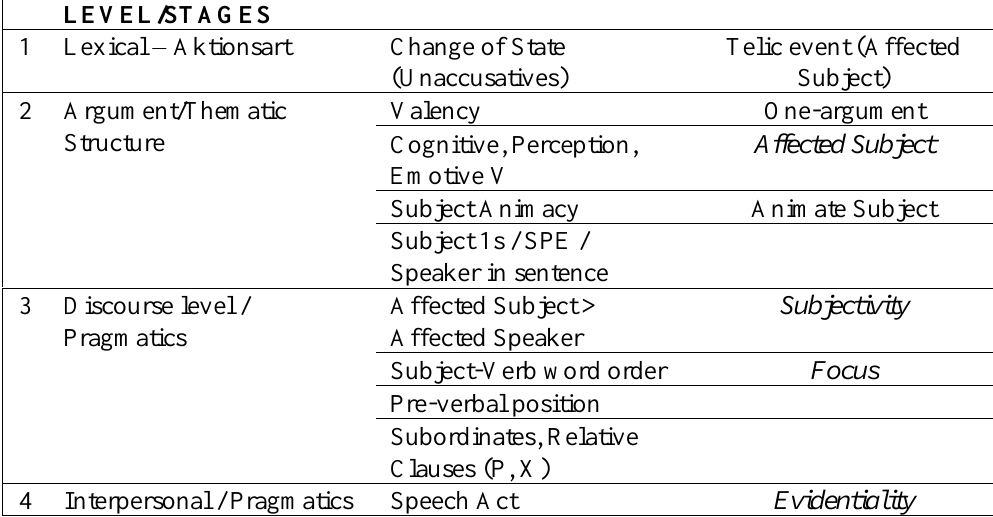
Table 12. Andean Spanish Present Perfect evidential grammaticalization